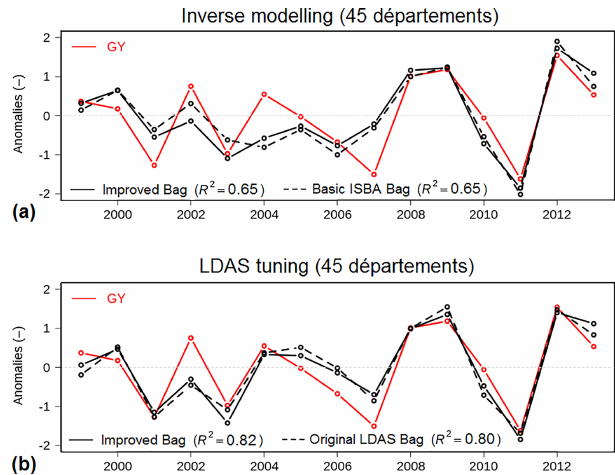
) and scaled sim- Figure 7. Scaled GY observation anomalies ( A s GY ) after LAI observation integration ulated B ag X anomalies ( A s B ag X for all 45 départements: (a) inverse modelling and (b) LDAS tuning. Red lines are for observations, dark lines are for simulations, dark dashed line is for the original un-tuned simulations. The fraction of explained variance by A s is R 2 = 0.65 for inverse modelling, B ag X and 0.82 for LDAS